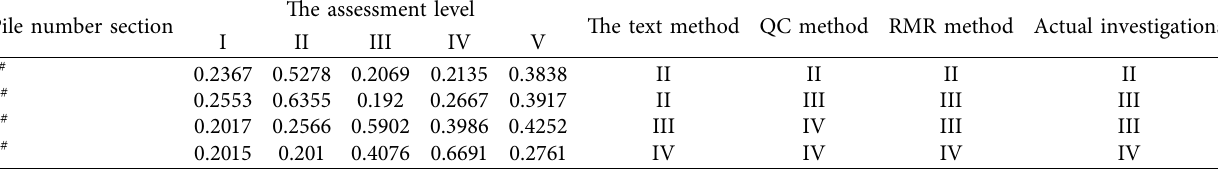
Table 5: The assessment of surrounding rock level and comparison.